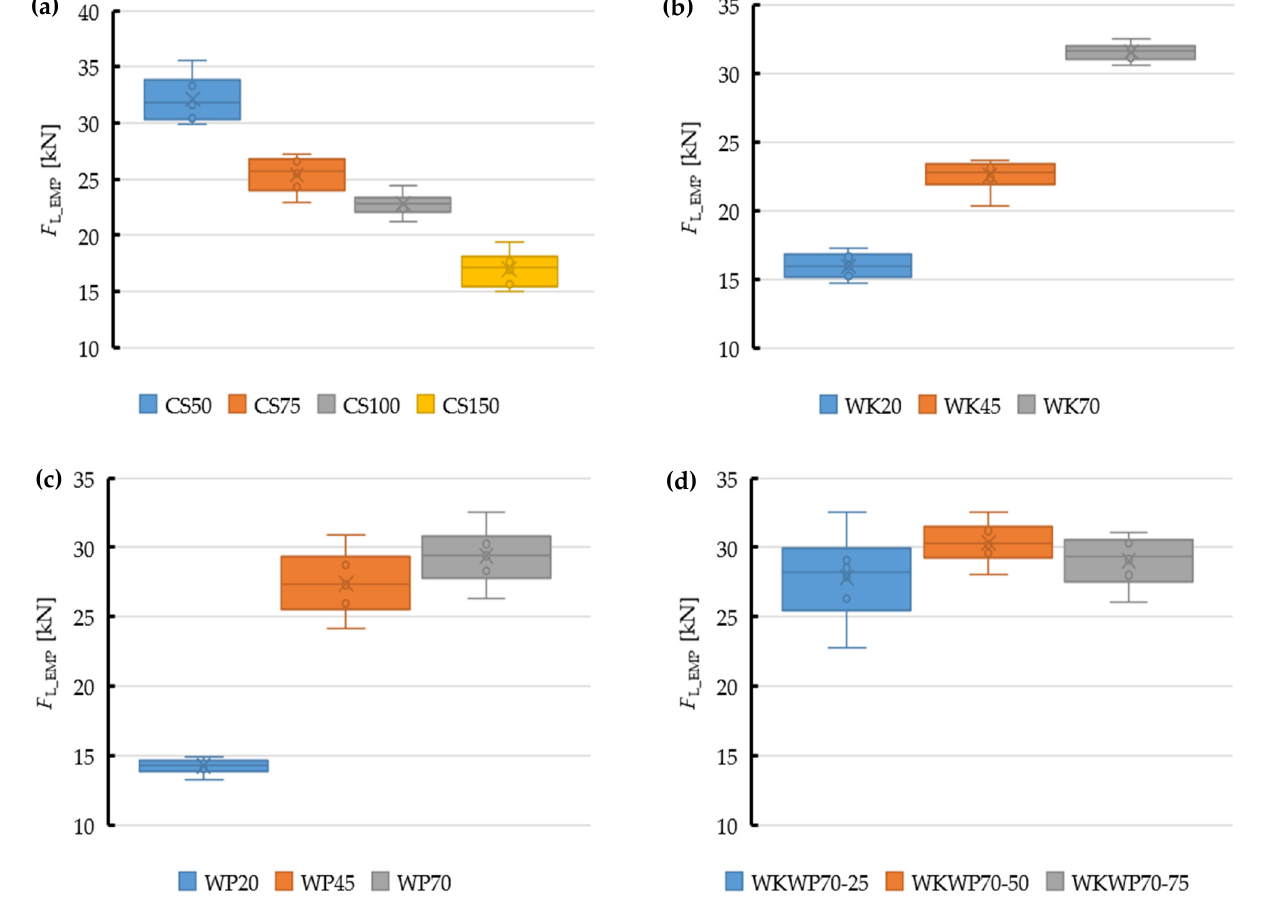
Figure 12. Box plots relating the median of the maximum observed extrusion force F L_EMP with statistical data obtained for the dies under analysis, i.e., CS ( a ), WK ( b ), WP ( c ) and WKWP ( d ).